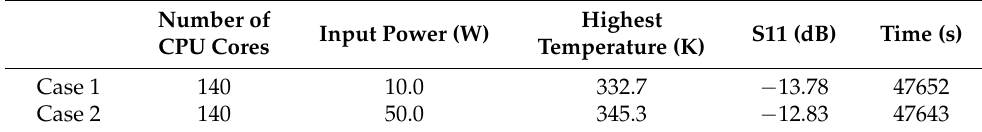
Table 2. Information of real-life System-in-Package multiphysics simulation.